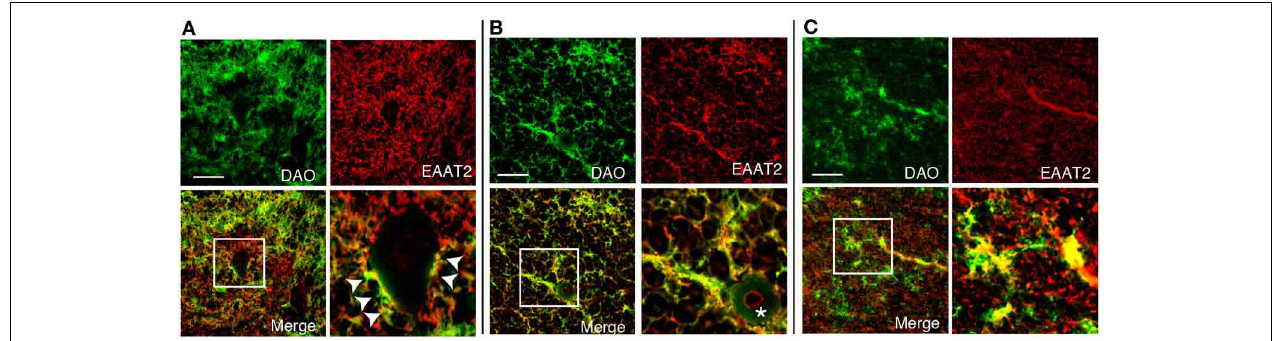
FIGURE 4 | Colocalization of DAO enzymatic activity and EAAT2. DAO enzyme histochemistry was performed after immunohistochemistry of EAAT2 in human thoracic spinal VH (A) , spinal LCST (B) , and white matter of PMC